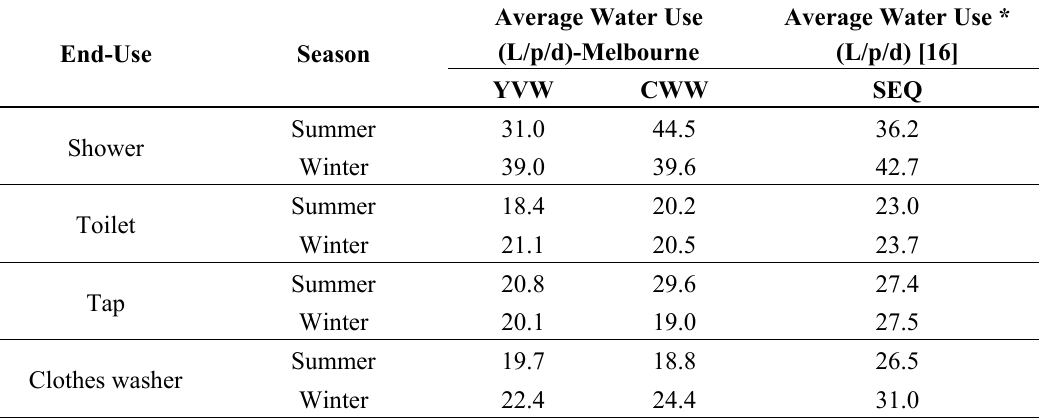
Table 5. Comparison of average end-use water consumptions